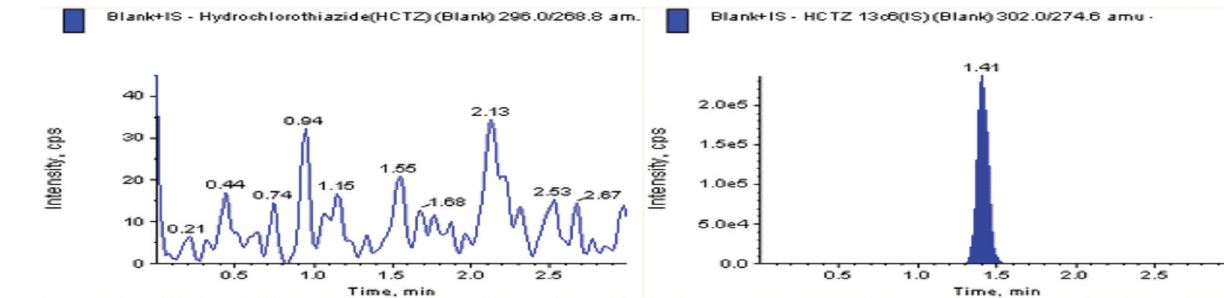
FIGURE 6 - Representative chromatogram of blank plasma sample with HCT-IS.